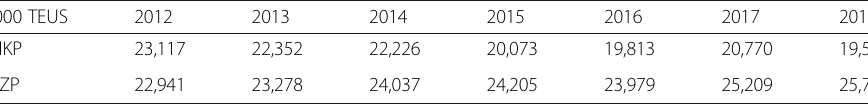
Table 2 Ranking of Container Ports of